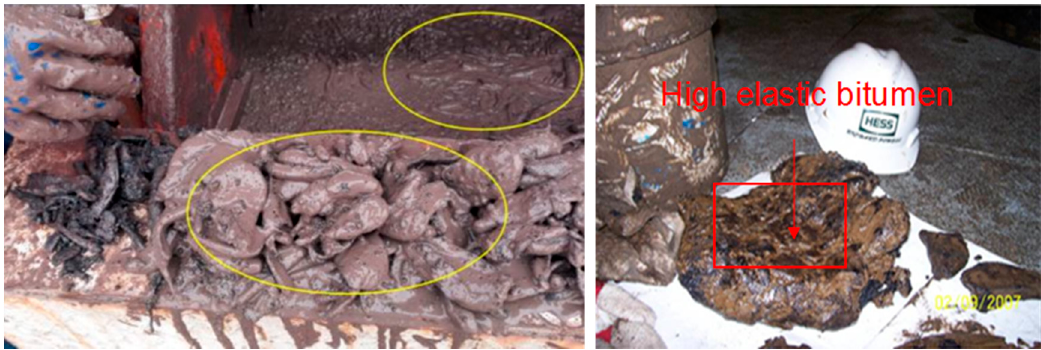
Figure 1. Typical formation of bitumen drilled in the oil-gas drilling process.